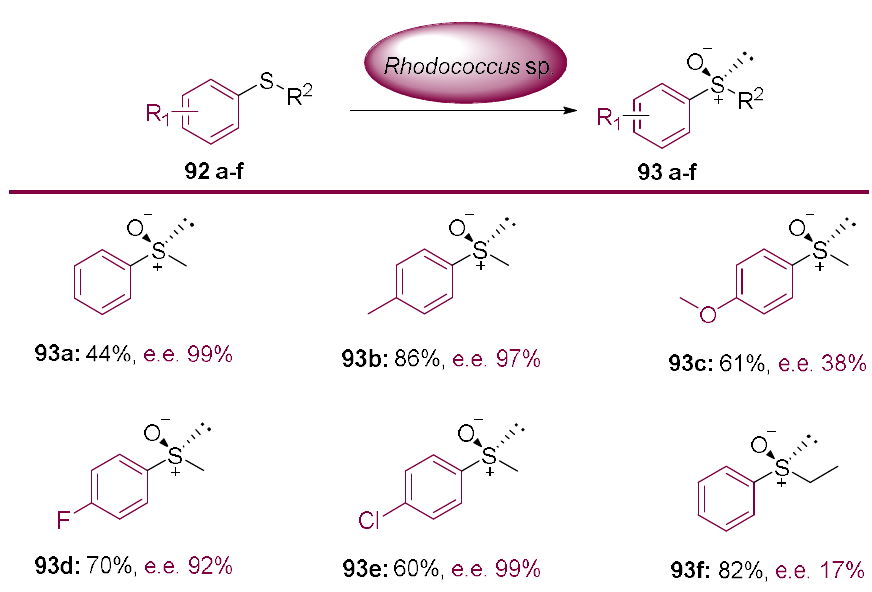
Scheme 26. Oxidation of sulfides by Rhodococcus sp.